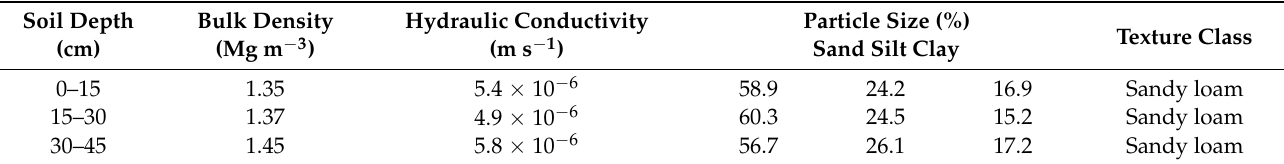
Table 1. Main physical properties of soil at the experimental site.